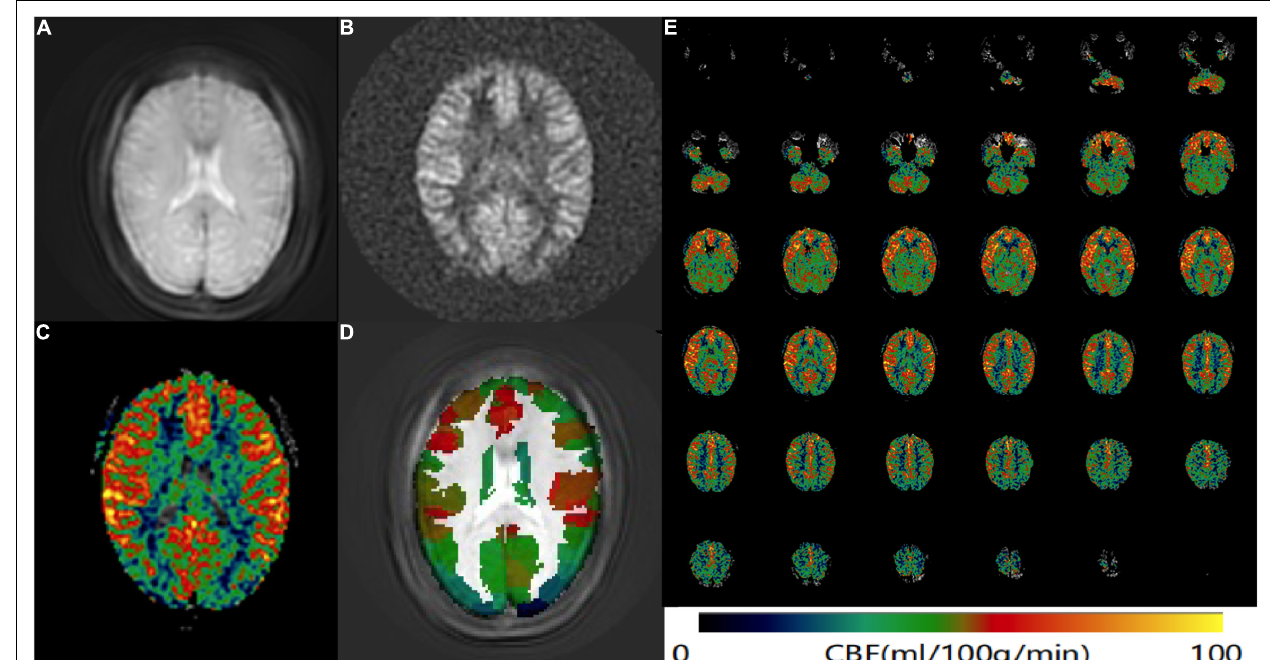
Frontiers in Neuroscience |